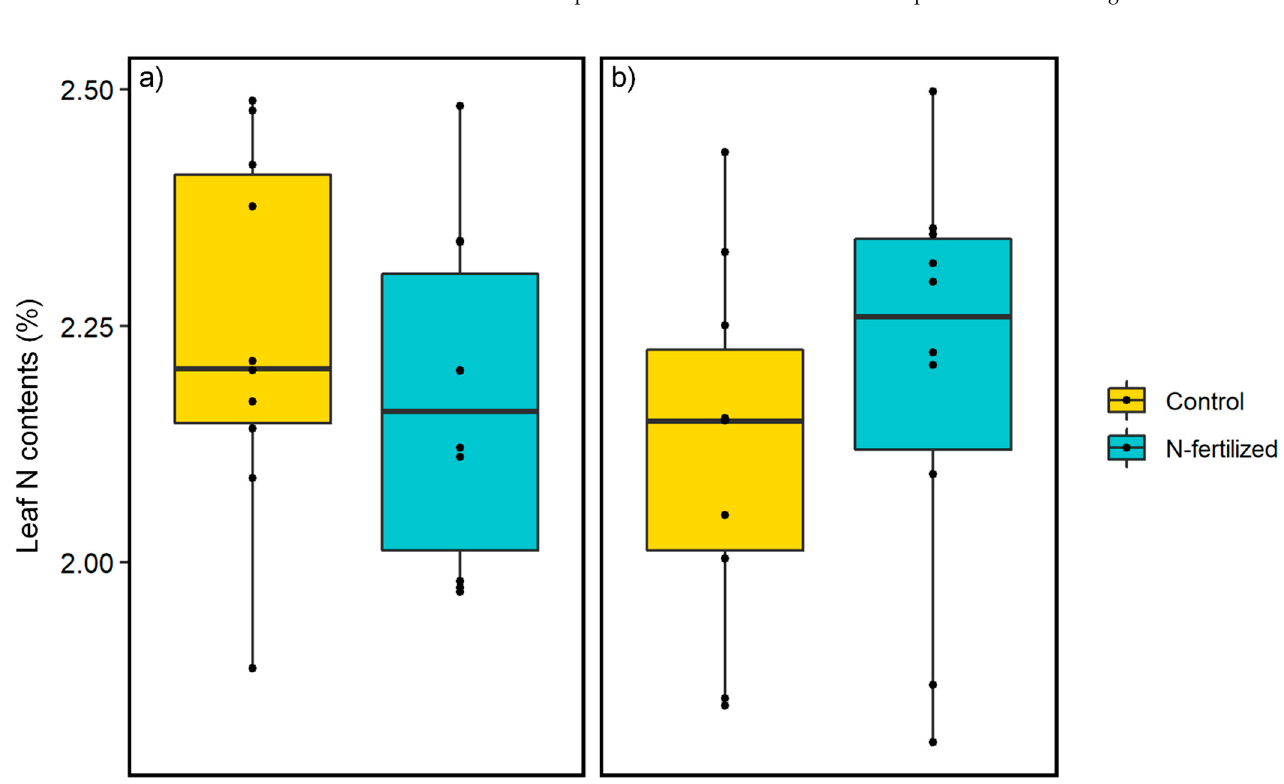
Figure 5. Micrographs of xylem for the dye injection experiment. ( a ) A part of a cross ‐ sectional disc at 0.5 m from the dye injection site. The arrow shows stained large ‐ diameter outermost vessels. ( b ) The outermost vessels in a radiation cross ‐ sectional face. The arrow shows the fluorescent dye in the vessel lumen. ( c ) The outermost vessels in a cross ‐ sectional face. The arrow shows the fluorescent dye in the vessel lumen and the annual ring boundary. L = large vessel. S = small vessel.